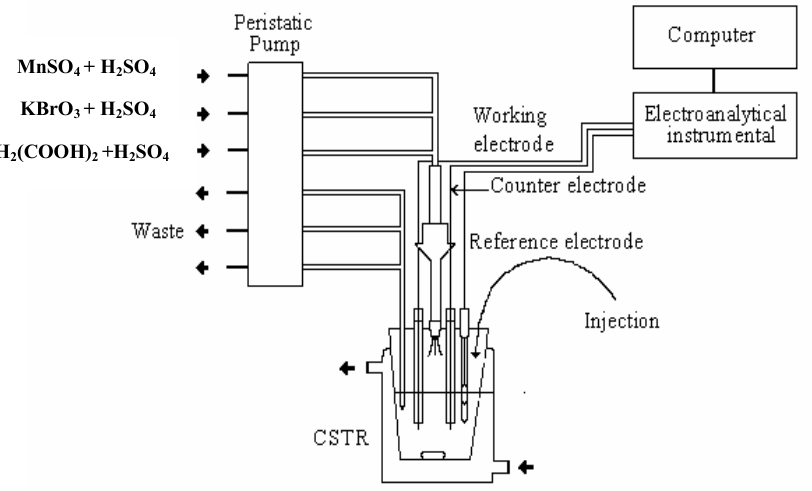
Fig. 1 Experimental set-up for the determination of sulfanilamide based on Mn(II)-BrO − CH 2 (COOH) 2 -H 2 SO 4 oscillating